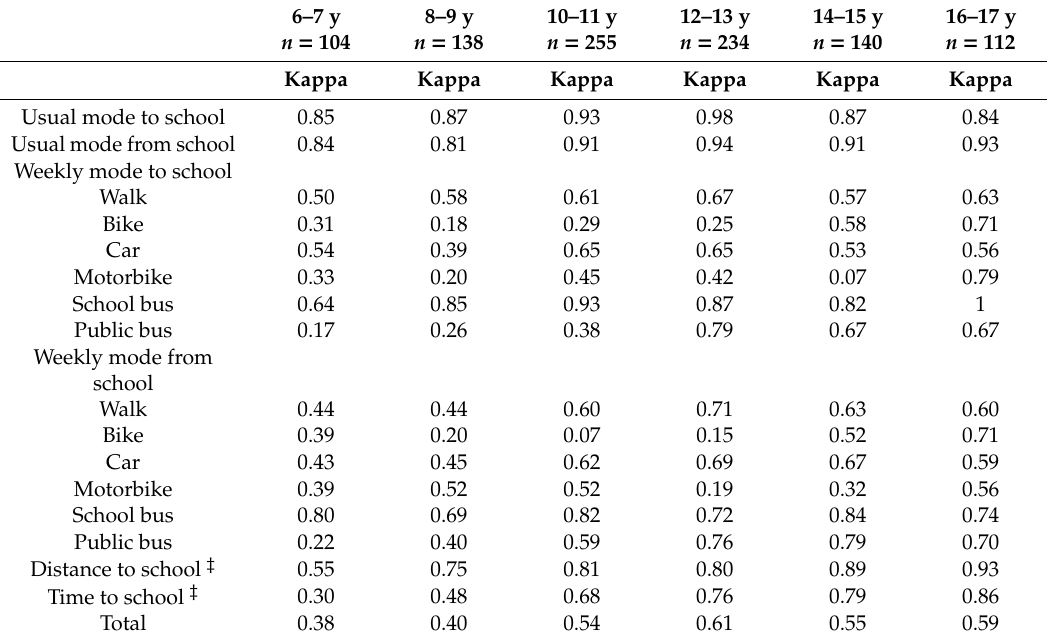
Table 4. Test-retest reliability of the “New Version of Mode and Frequency of Commuting To and From School” questionnaire by age